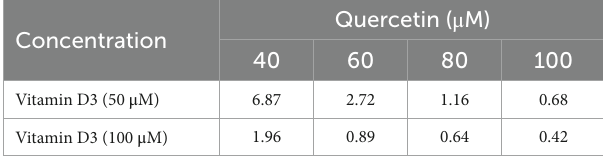
TABLE 2 Interpretation of drug combination index values in BT-474.